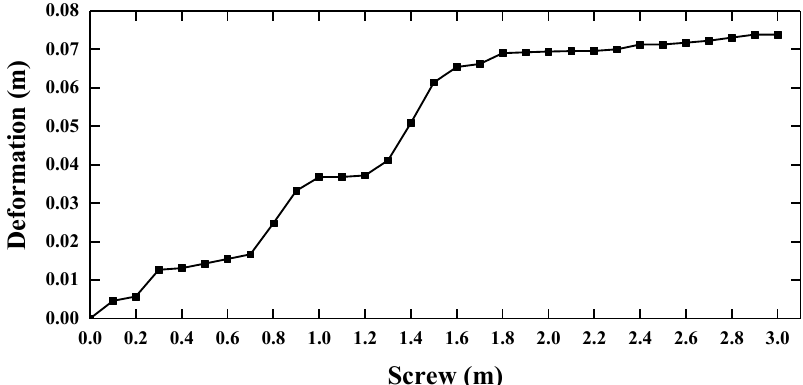
Figure 11. The radial deformation of the lead screw without a support slider.